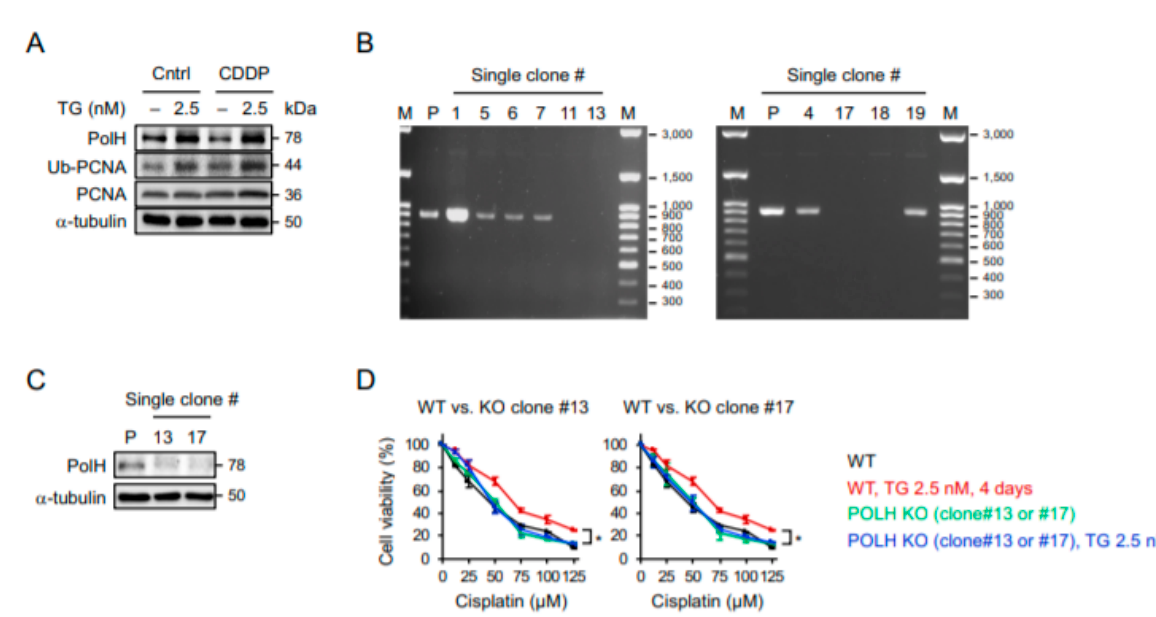
Figure 5. Polymerase η is up-regulated in ER stress-adapted cells and is required for their acquisition of cisplatin resistance. ( A ) OECM1 cells with or without 4 days of 2.5 nM thapsigargin pretreatment were treated with 100 µ M of cisplatin for 1 day, and the expression of polymerase η , proliferating cell nuclear antigen (PCNA), and ubiquitinated PCNA (Ub-PCNA) were examined by Western blots. The α -tubulin was used as the loading control. ( B ) PCR analysis of single-cell clones following clustered, regularly interspaced, short palindromic repeat RNA-guided (CRISPR)-based knockout of POLH using primers designed to amplify the region flanked by sgRNA docking sites. ( C ) Western blot analysis of the expression of polymerase η in two identified POLH-knockout clones. ( D ) WST-8 assay of cell viability after treatment with various doses of cisplatin. Data from three independent experiments are shown as the mean ± SEM. Statistical significance was determined by one-way ANOVA. *, p < 0.05.